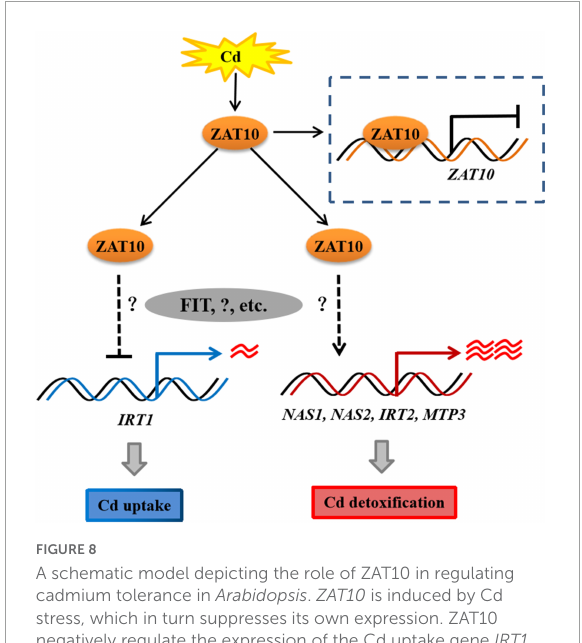
FIGURE8 A schematic model depicting the role of ZAT10 in regulating cadmium tolerance in Arabidopsis . ZAT10 is induced by Cd stress, which in turn suppresses its own expression. ZAT10 negatively regulate the expression of the Cd uptake gene IRT1 , leading to a reduction in Cd uptake in plants. ZAT10 also promotes the expression of the Cd detoxification genes NAS1 , NAS2 , IRT2 , and MTP3 , to enhance the detoxification of Cd in plants. Dashed lines with a question mark denote unclear regulatory